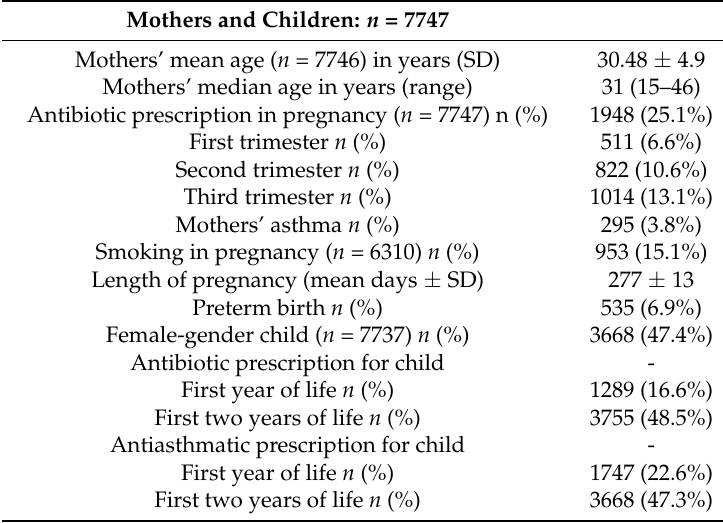
Table 1. Background information about the cohort of mothers and